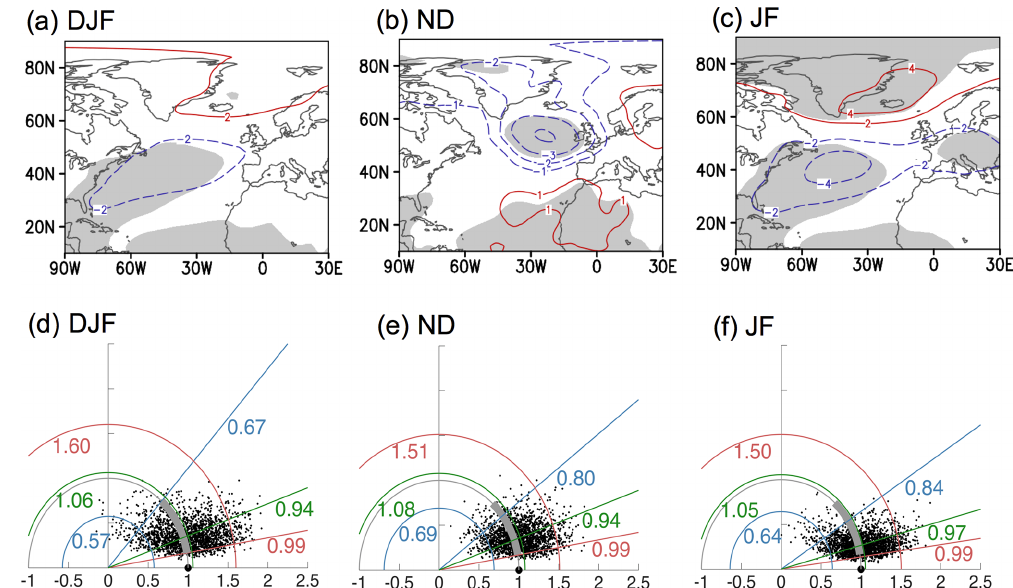
Figure A2. Similar to Figs. 1 and 2 except for a longer period of 1870–2014. (a–c) SLP composites for El Niño minus La Niña events. The contour interval in panels (a) and (c) is 2hPa, and it is 1hPa in panel (b) , with red (blue) contours indicating positive (negative) anomalies. Gray shading indicates a 5% significance level for a two-tailed t test. (d–f) Corresponding Taylor diagrams for the North Atlantic with 2000 bootstrap SLP composites. Features in the Taylor diagrams are as described in Fig. 2. See Sects. 2.4 and 3.1 for more details.